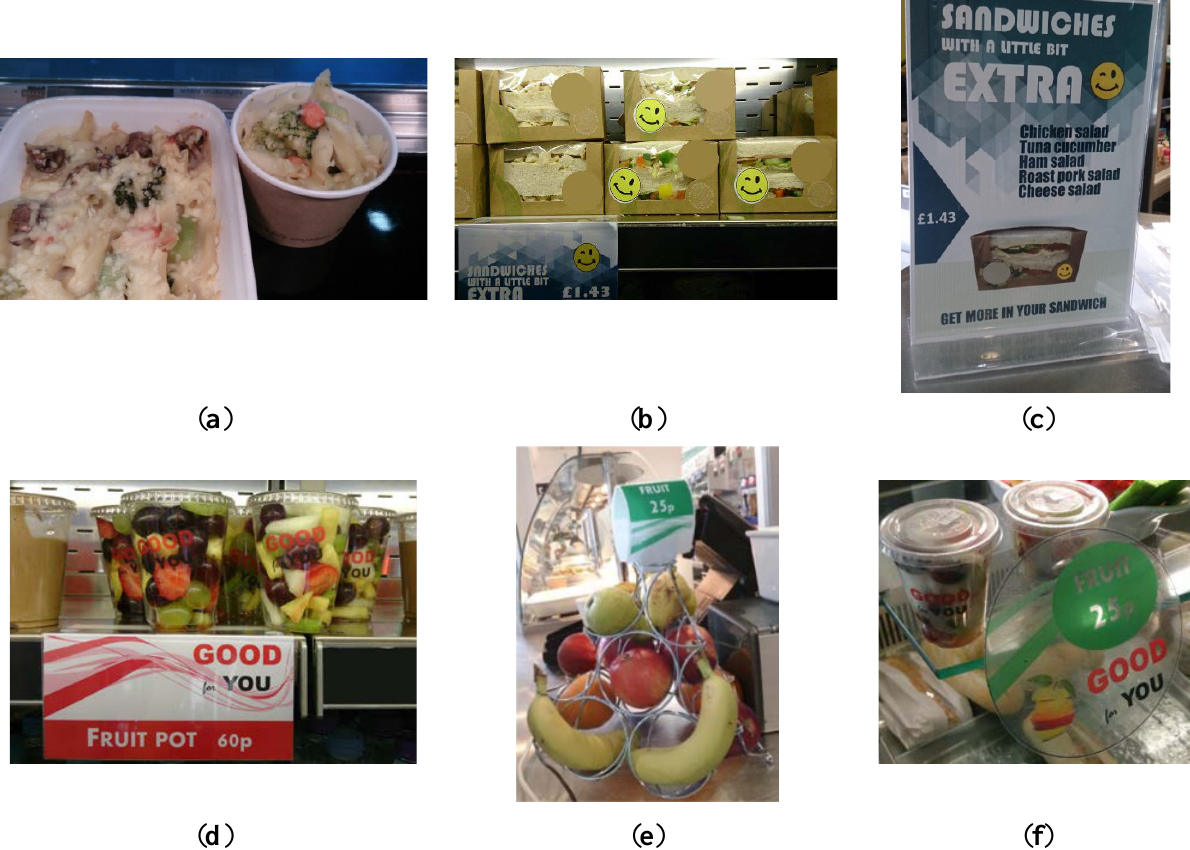
Figure 1. Some of the nudge strategies implemented for designated food items during the intervention: ( a ) disposable pots for freshly prepared vegetarian daily specials;